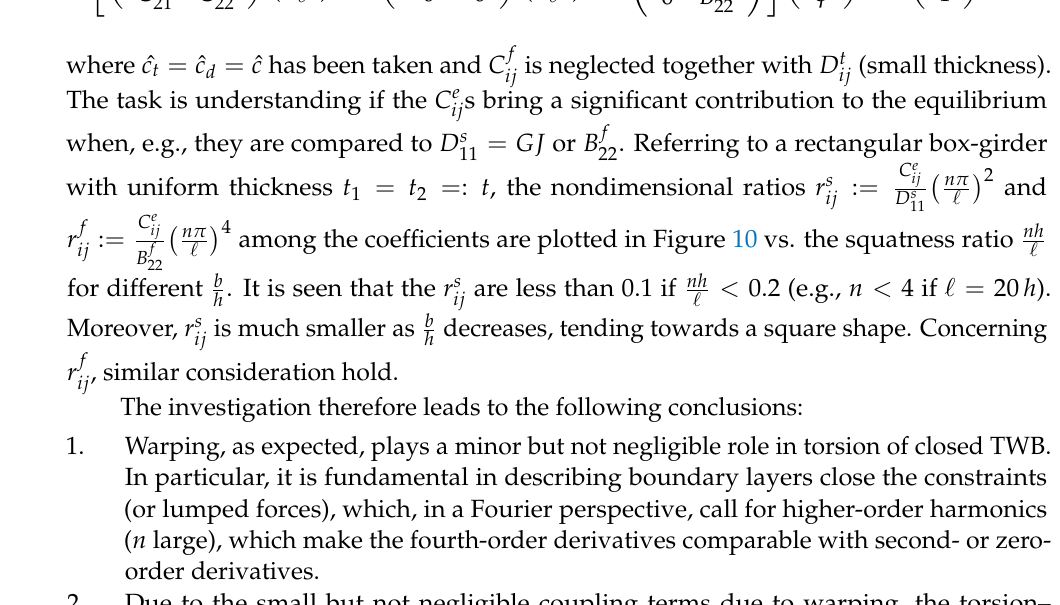
Figure 10. Influence of the fourth-order terms on the sinusoidal solution: ( a – c ) extensional-to-shear ratios r s ( d – f ) extensional-to-flexural ratios r f dashed lines), and h